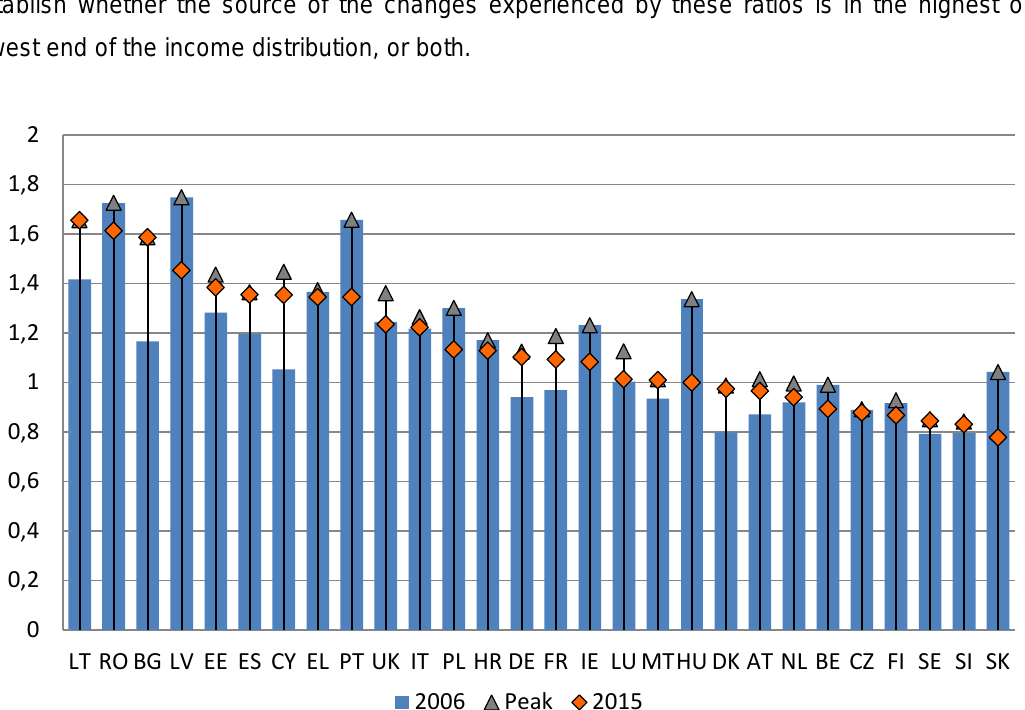
Figure 4 . Palma ratio in the EU-28 countries (2006, 2015, and period peak). Source: Own elaboration based on statistics from Eurostat. Notes: (i) Countries appear ranked according to the highest Palma ratio in 2015. (ii) Croatia's data correspond to 2010 instead of 2006; Romania's data correspond to 2007 instead of